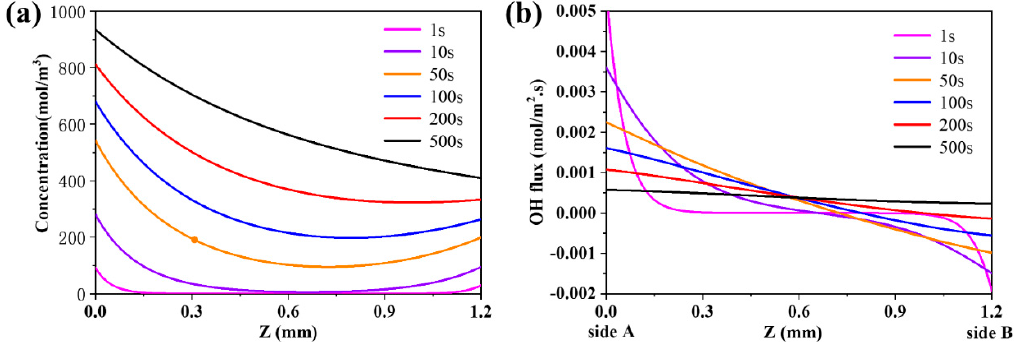
Figure 3. ( a ) The evolution of the distribution of proton concentration in the BCY10 membrane; and ( b ) the evolution of the flux of proton at 1000 K.